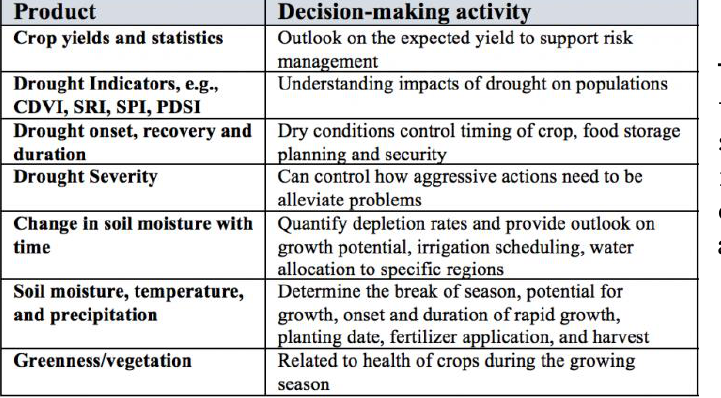
Table 2 : Suite of data